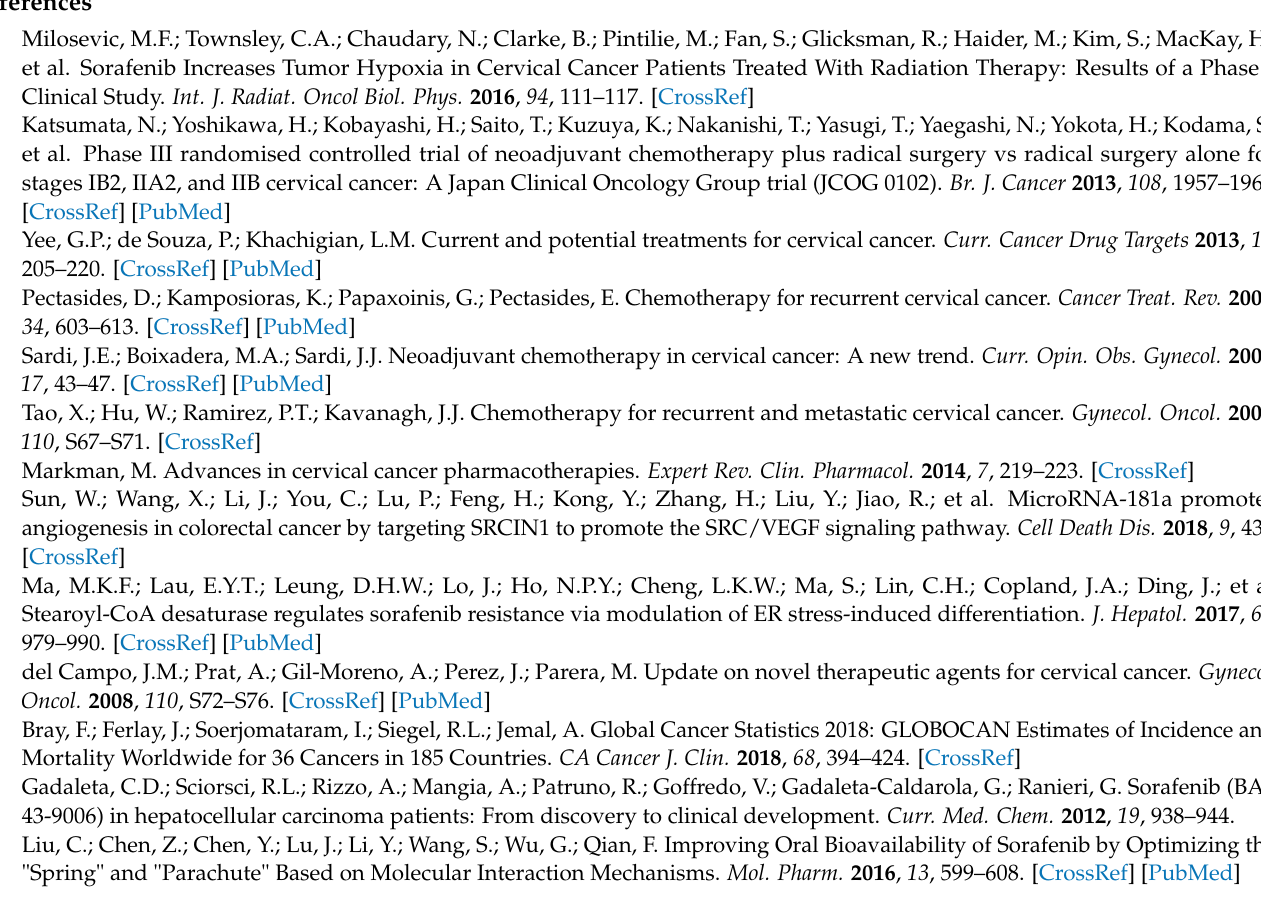
Figure A8. H&E-stained microscopic images of major organs of mice by the end of treatment (intravaginal administration every 3 days for continuous 16 days at SF dose of 15 mg/kg/3d). Scale bars = 100 μ m.